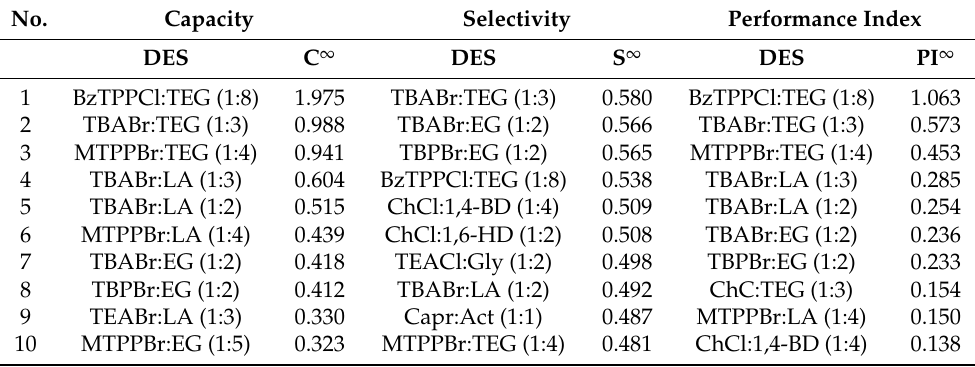
Table 2. The top 10 DESs according to COSMO-RS screening by C ∞ , S ∞ and PI ∞ for the separation of 1-hexene and toluene.